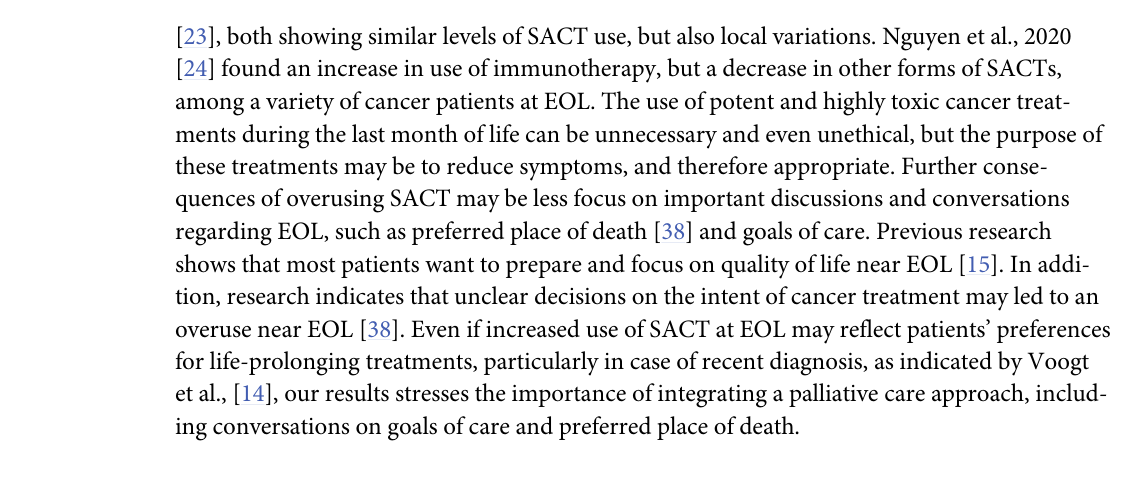
Fig 3. Moderation effects of specialized palliative care (SPC) at home on the difference between the years of 2010 and 2017 in patients dying in acute care hospital.